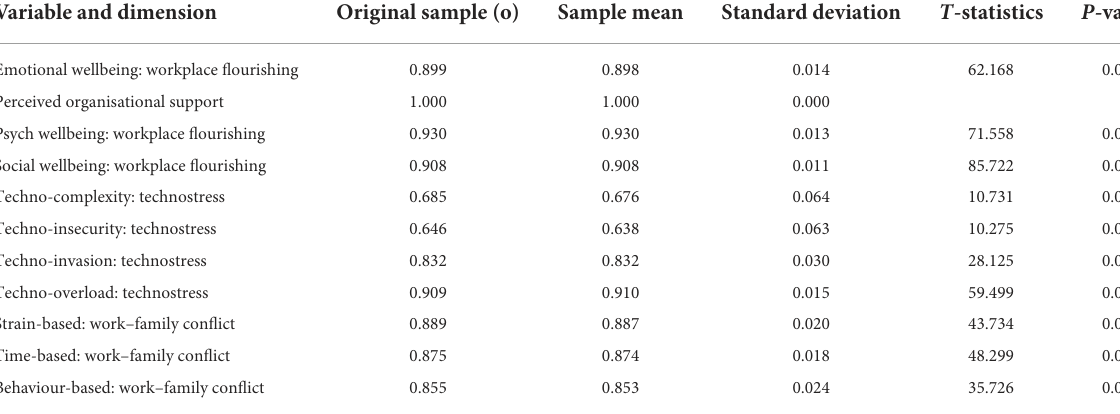
TABLE 4 Indicator loadings: the outer model.